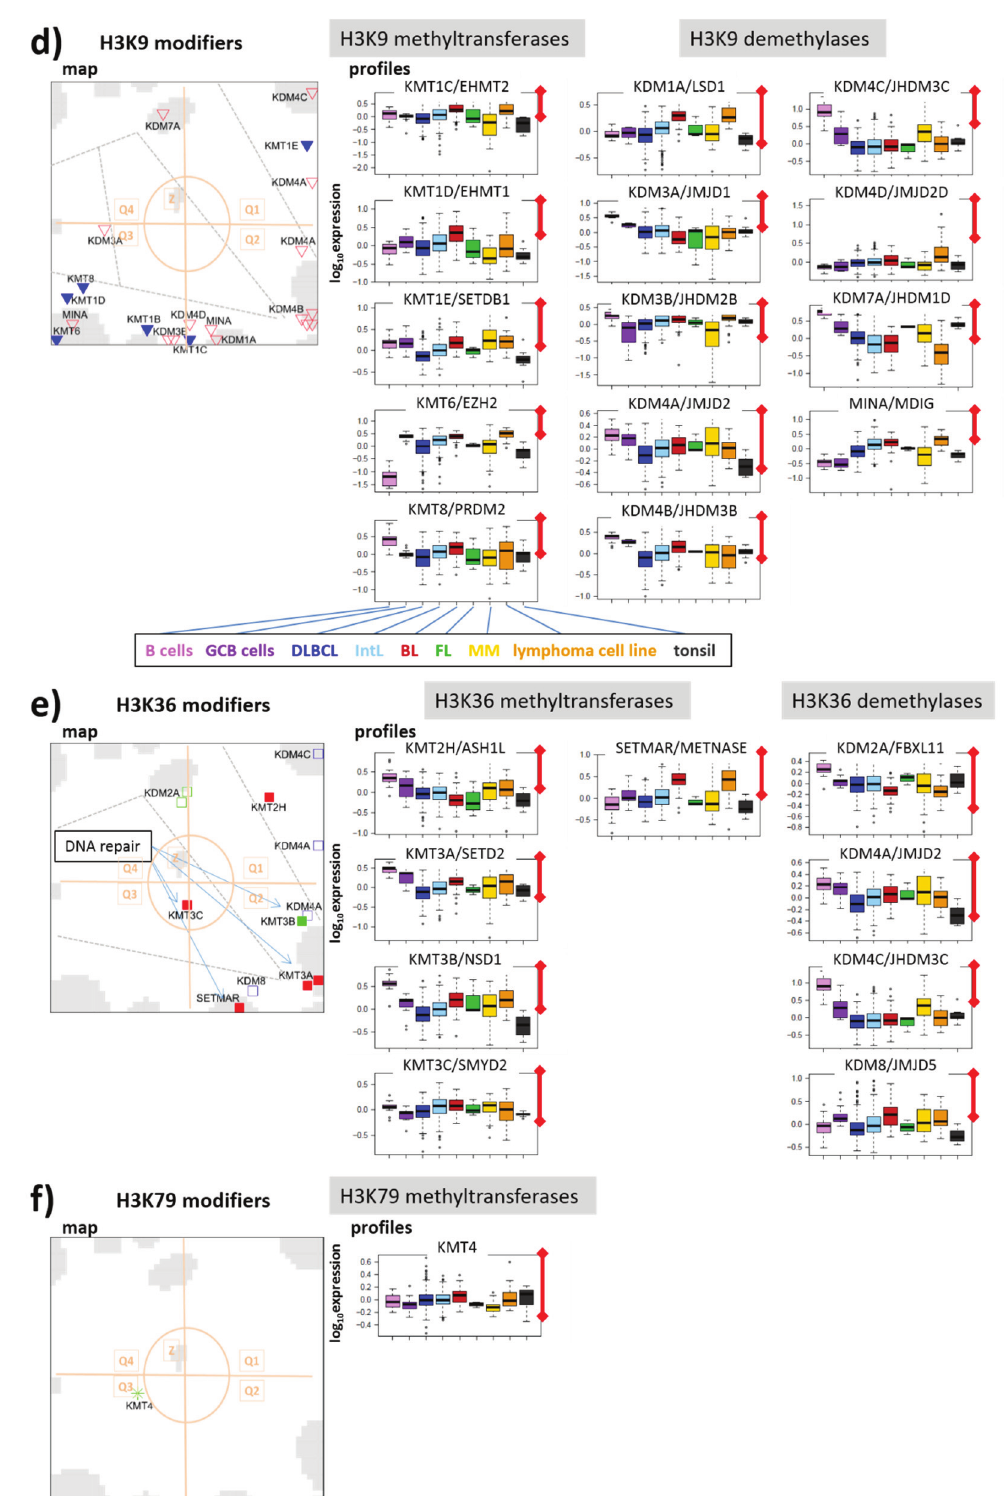
Figure 7. Group-wise mapping of writers and erasers of methylation marks at CpGs and lysine side chains of histone subunit H3 and their expression profiles: ( a ) DNA, ( b )